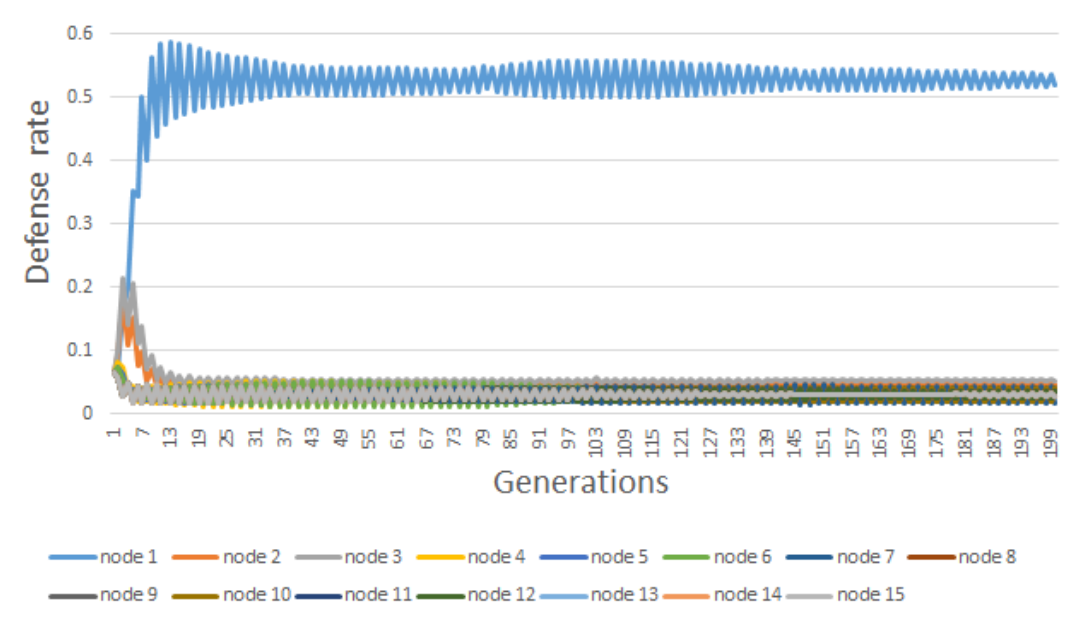
Figure 5. Evolution graphs for average defense rate showing the results for the nodes of the case study. The defender’s budget equals to 1.0. The x-axis presents the generations. The y-axis presents the evolution of average